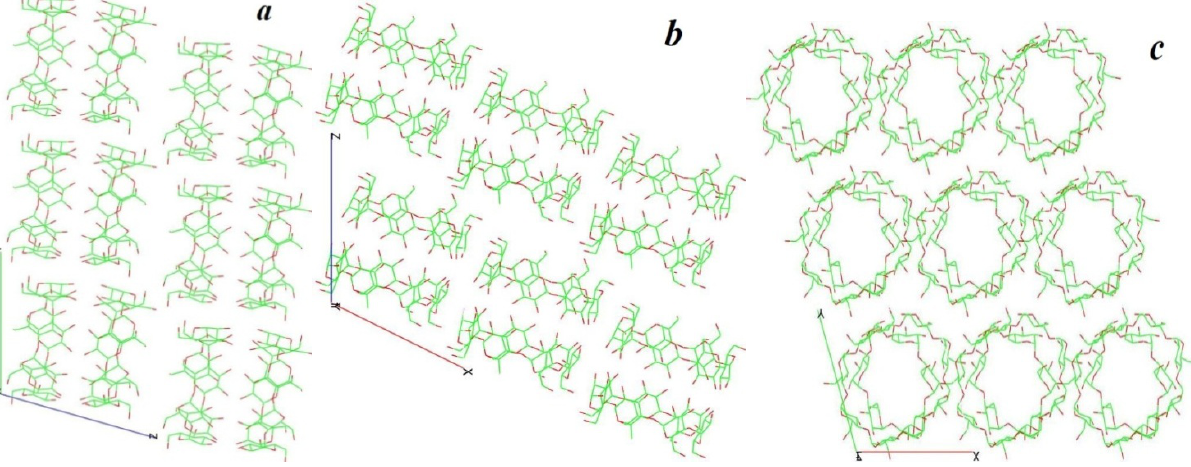
Figure 5. Crystal packing of β -cyclodextrins in the 1-BCD crystal structure shown along the a , b and c directions. Guest molecules (aegelinol) and waters are omitted for